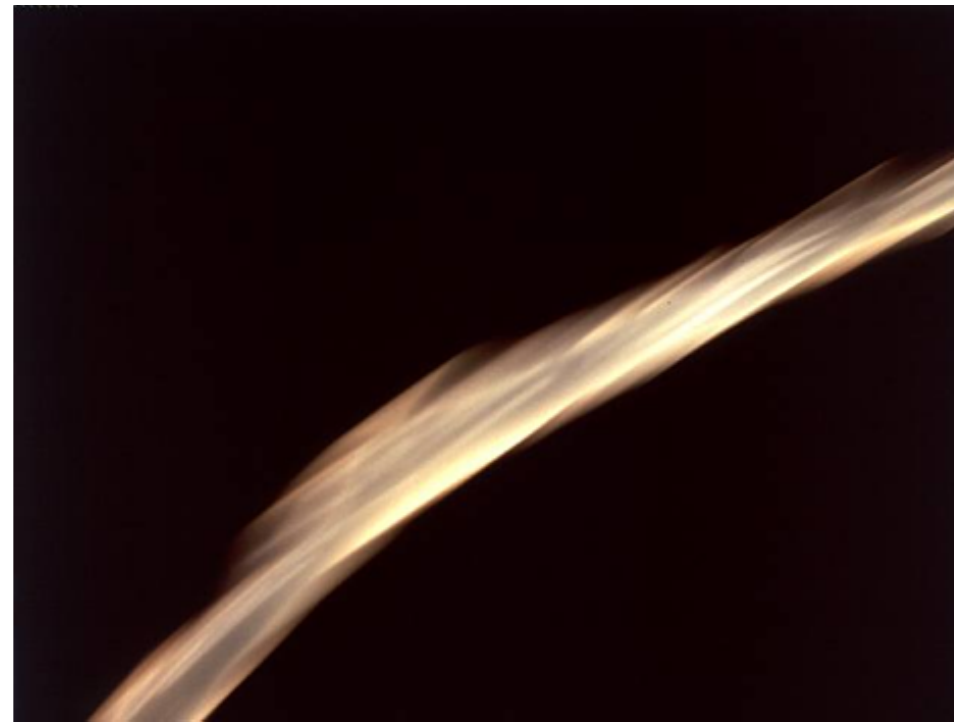
Andres Serano, Untitled VII (Ejaculate in Trajectory) , 1989. Cibachrome print, 40 x 60 in. (101.6 x 152.4 cm) . Courtesy of Edward Tyler Nahem Fine Art, New York